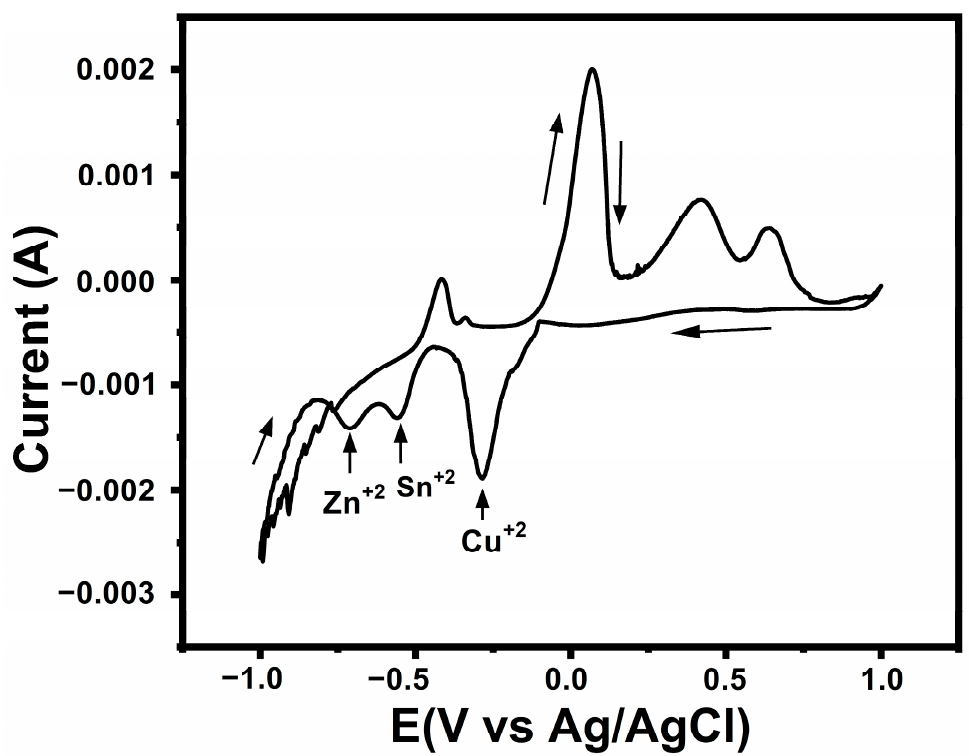
Figure 1. Cyclic voltammetry (CV) with scan speed10 mVs − 1 ; with the calculated reduction potentials of Cu, Zn, and Sn.